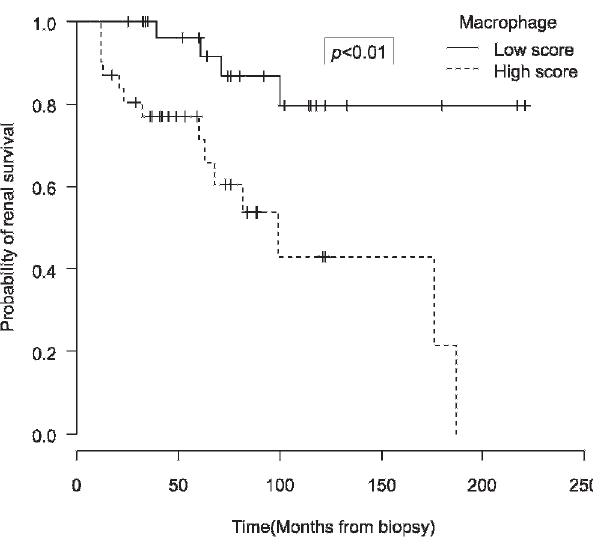
function of the number of macrophages. A low score corre- sponded to those cases with a number of cells below the median of 7.14 cells/mm2, and a high score corresponded to those cases with a number of cells above the median value. The end-point for renal survival was defined as ESRD (end-stage renal disease) requiring dialysis or transplant. The vertical hash marks on the survival curves indicate the end of follow-up for patients who did not